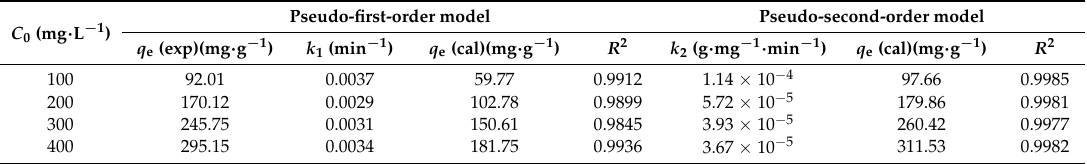
Table 2. Parameters of intra-particle diffusion model for MB